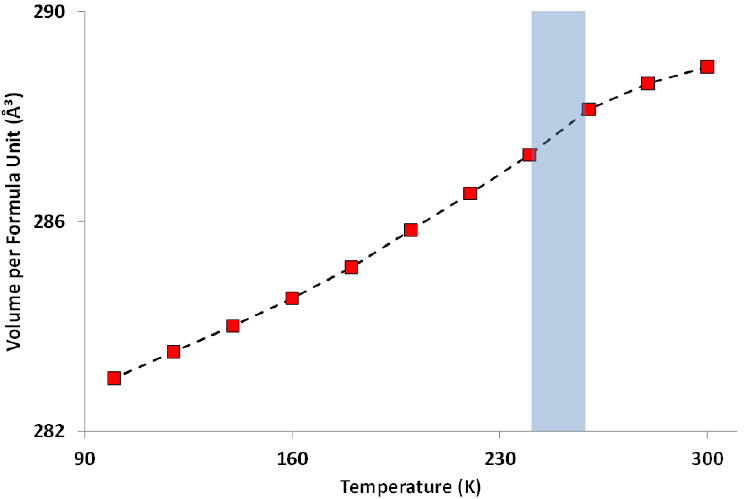
Figure 5. SXPD patterns for Cs 2 TiCu 3 F 12 at a range of temperatures; note peak splittings appearing below 260 K.